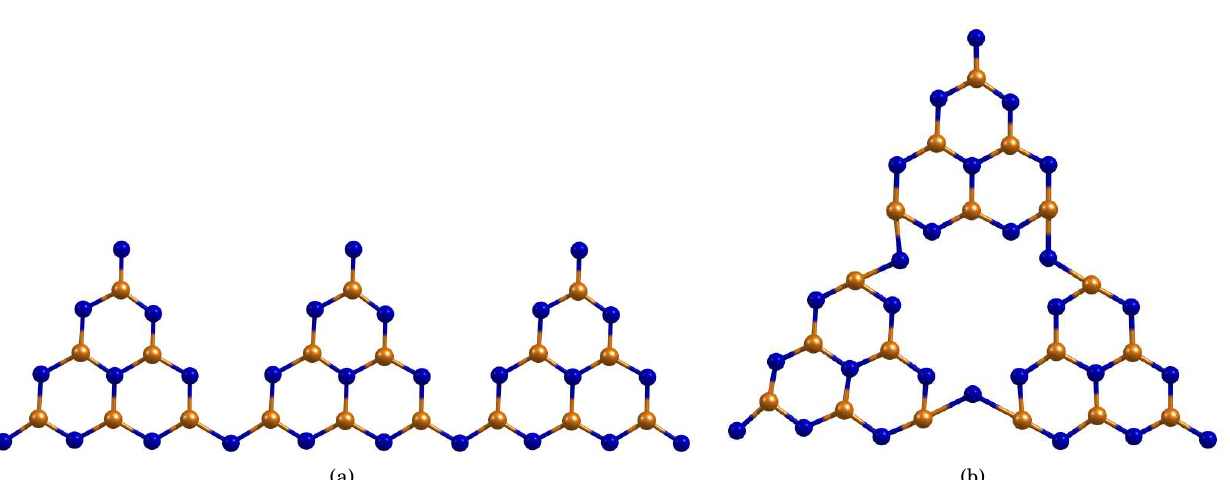
Figure 1: Melem structure with three units (a) Chain form (b) Ring